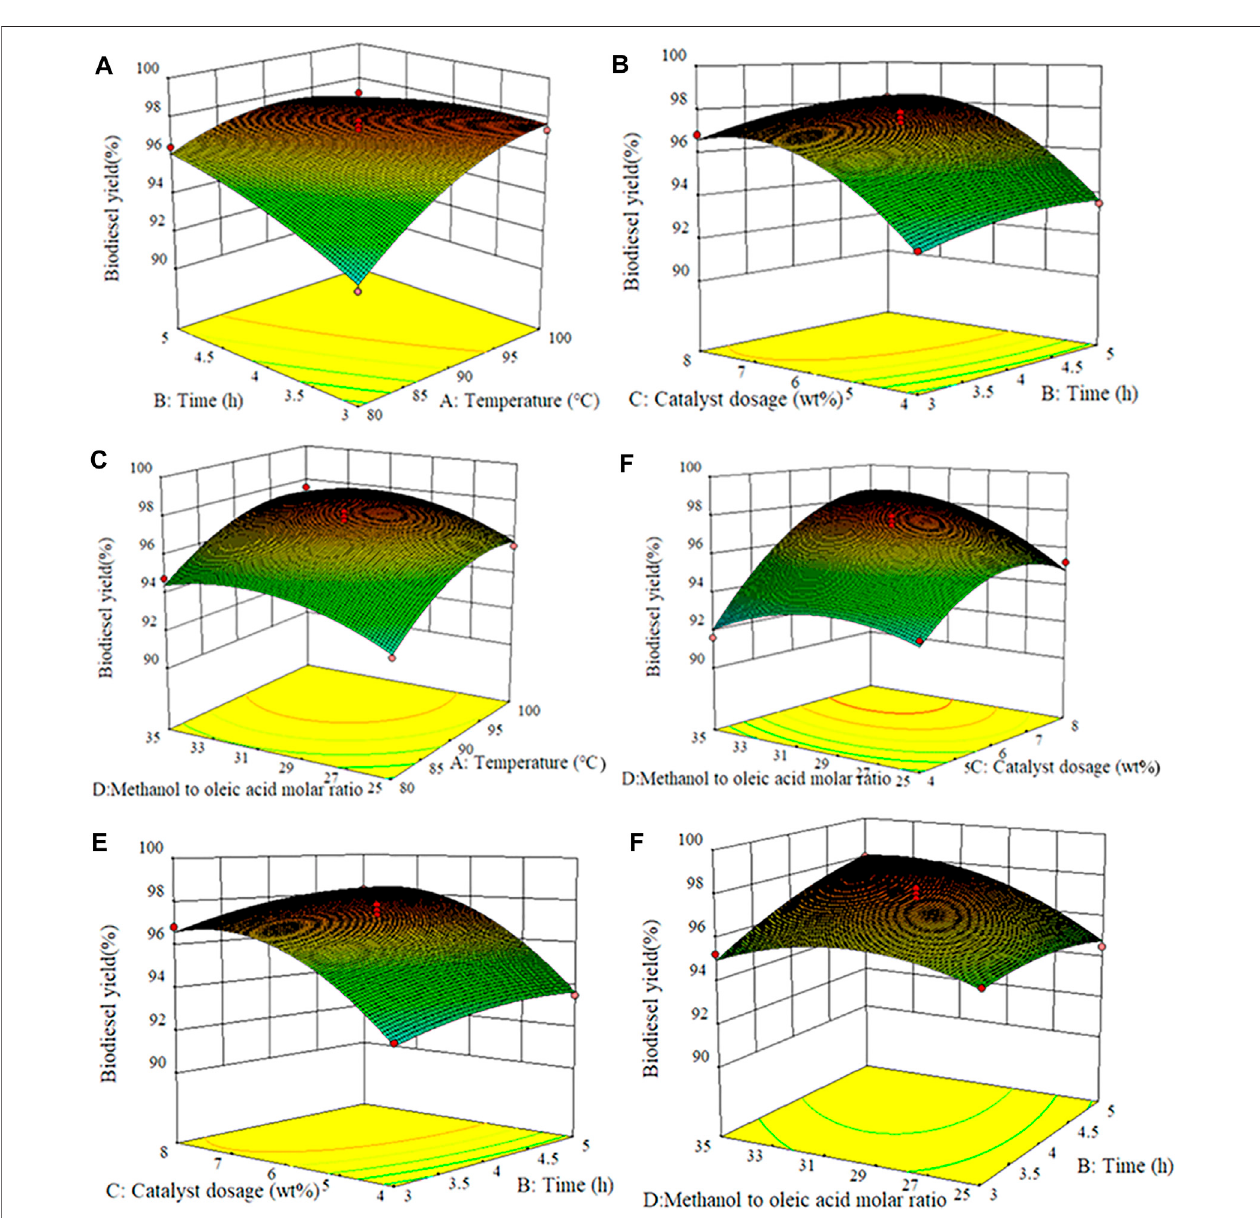
FIGURE5| Surfaceresponseplotsofdifferentexperimentalvariablesagainstbiodieselyield. (A) Temperatureandtime, (B) timeandcatalystdosage, (C) methanol to oleic acid molar ratio and temperature, (D) catalyst dosage and methanol to oleic acid molar ratio, (E) catalyst dosage and time, and (F) methanol to oleic acid molar ratio and